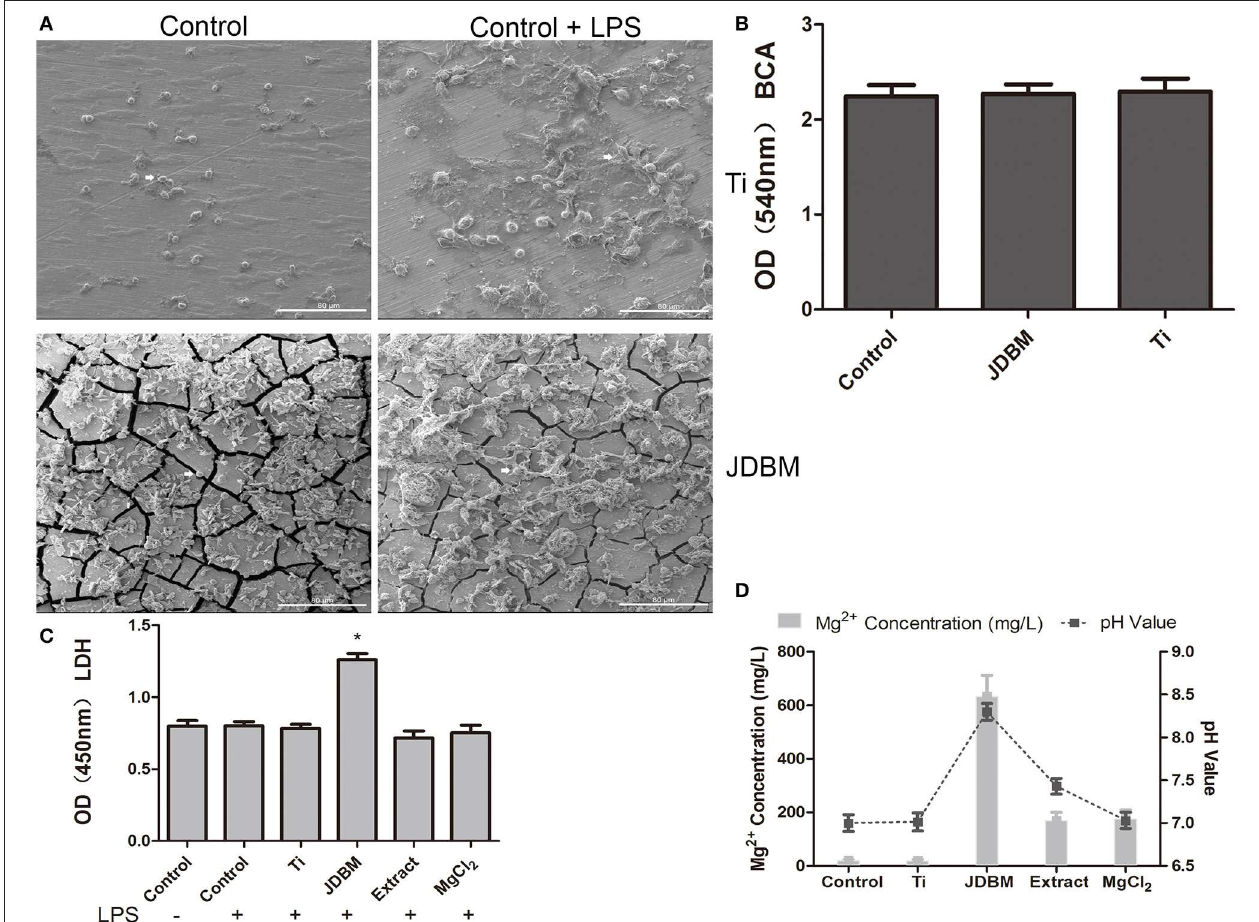
FIGURE 2 | The characterization of the effects of JDBM, Ti, extract, and MgCl 2 on the macrophages. (A) Macrophages were seeded on JDBM or Ti discs with or without LPS for 24h after immersion in culture media for 24h, and the cellular morphology of macrophages was visualized by SEM. Scale bar = 80 µ m. (B) The JDBM, Ti, and cell culture plates (CCPs) were immersed in culture media for 24h, and the protein concentration of supernatants was determined by the BCA assay. THP-1 cell-derived macrophages were precultured with JDBM, Ti, extract, and MgCl 2 for 1h prior to challenge with or without LPS for 24h. The supernatants were harvested to analyze the cytotoxicity (C) and the pH value and Mg 2 + concentration (D) . The representative images from three experiments are shown. * P < 0.05 vs. control group. JDBM, Mg–Nd–Zn–Zr alloy; LPS, lipopolysaccharide; SEM, scanning electron microscopy; BCA, bicinchoninic